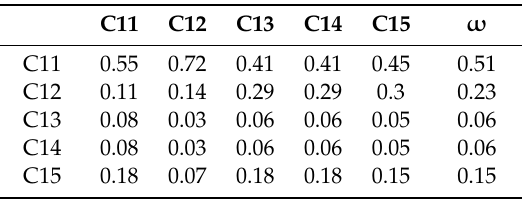
Table 5. The normalized matrix and the eigenvector.